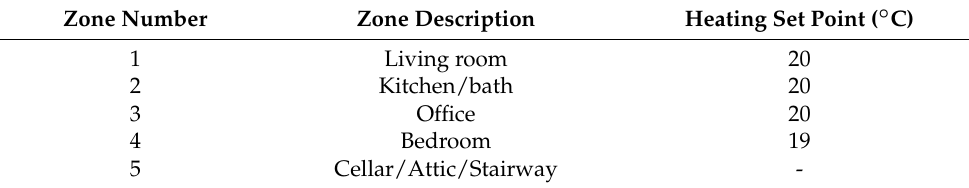
Table 2. Thermal zones of the building model with respective usage type and heating set point.